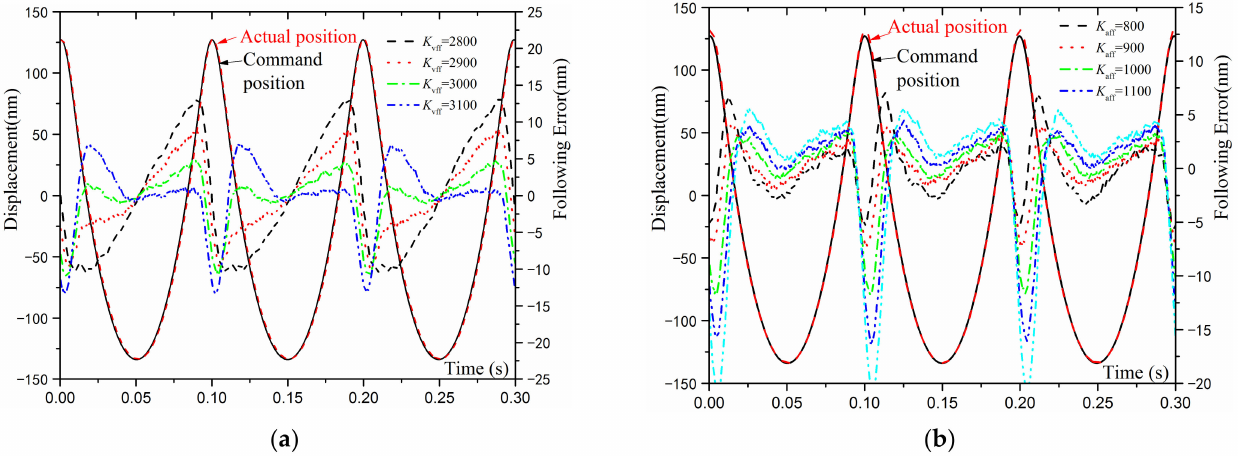
Figure 12. The tracking capability before and after the feedforward parameters adjustment: ( a ) Effect of K vff on FE, ( b ) Effect of K aff on